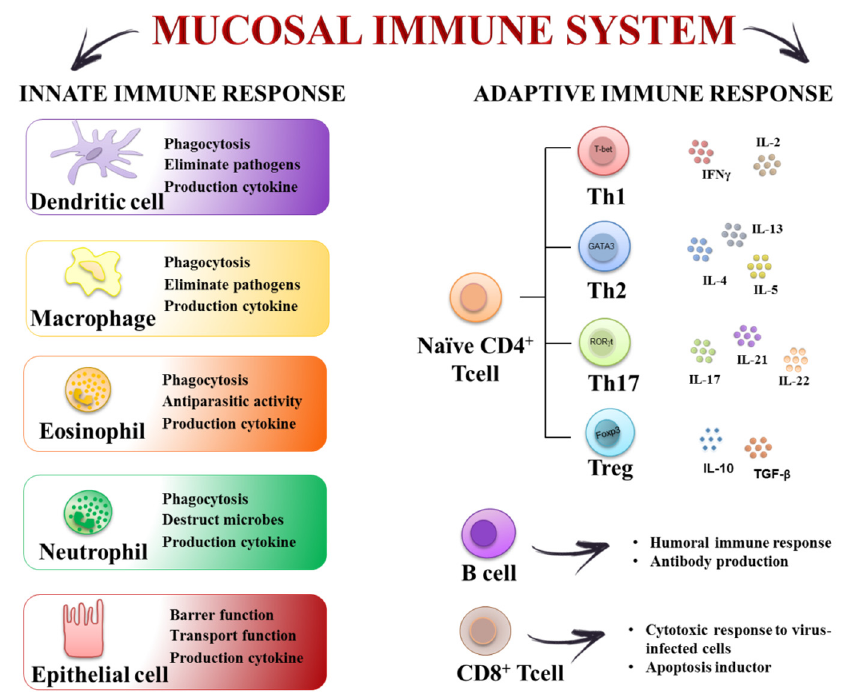
Figure 1. The mucosal immune system constitutes a key element in preventing penetration of microorganisms. It consists of innate and adaptive immune responses. The innate immune response is the first line of defense against infection and includes complement proteins, granulocytes (basophils, eosinophils and neutrophils), mast cells, macrophages, dendritic cells and natural killer cells. The adaptive immune response develops more slowly, but it is manifested as increased antigenic specificity and memory. It consists of antibodies, B cells, and CD4 + and CD8 + T lymphocytes. Disruption of the innate and acquired gut immune systems may cause the development of chronic intestinal diseases.